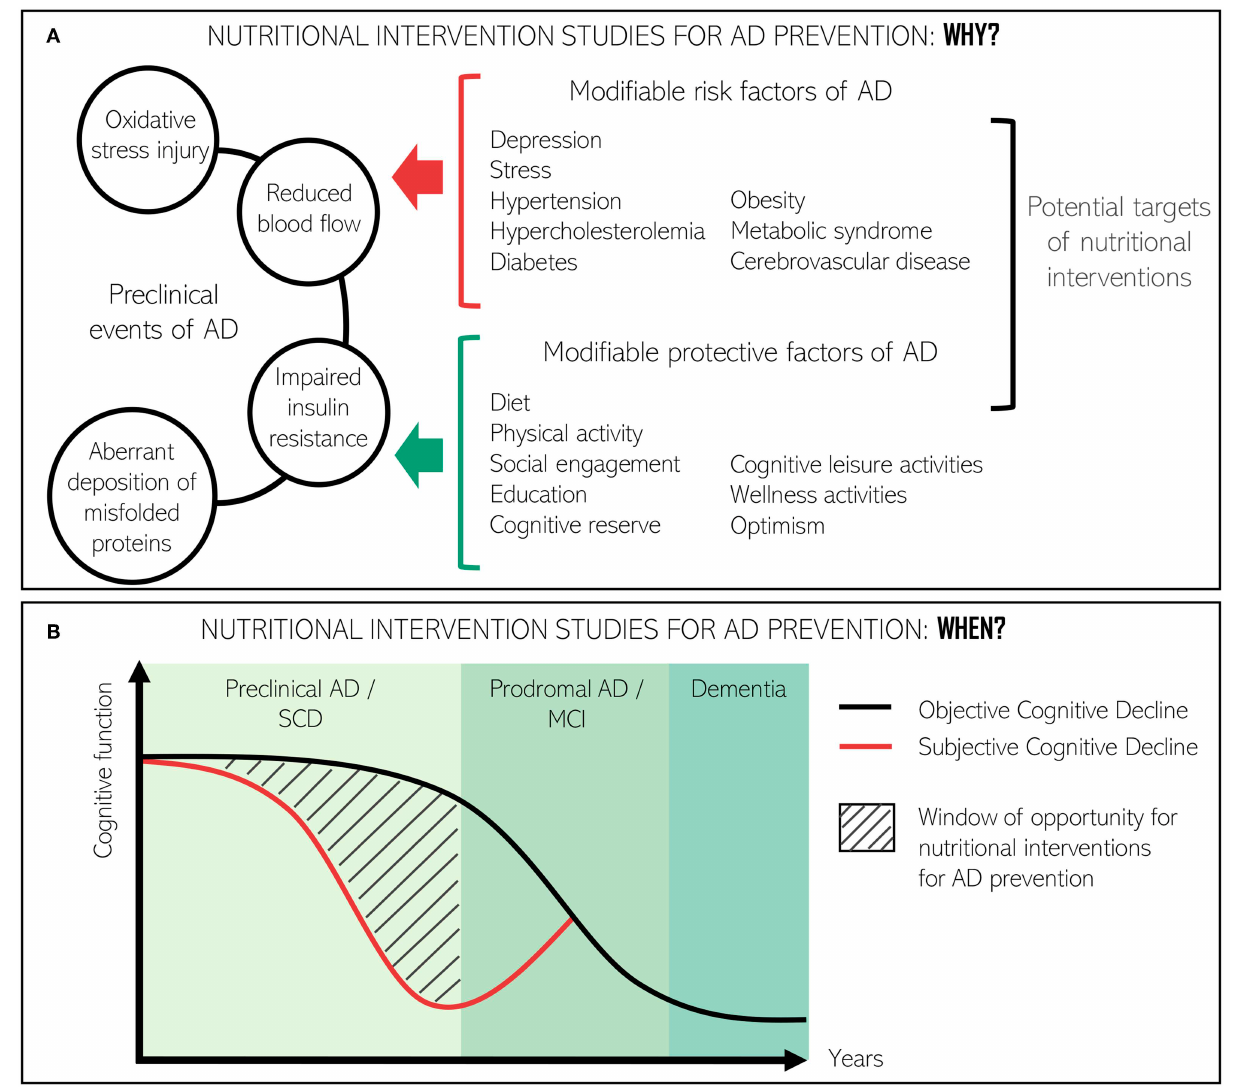
FIGURE 2 | Conceptual framework for the relevance of nutritional interventions directed at improving cognitive function or slowing down cognitive decline at preclinical stages of AD. (A) Role of nutritional interventions in the interaction between preclinical events of AD and modifiable risk and protective factors of AD. (B) Window of opportunity to study the effect of nutrition interventions in the AD continuum. Adapted from Ávila-Villanueva and Fernández-Blázquez